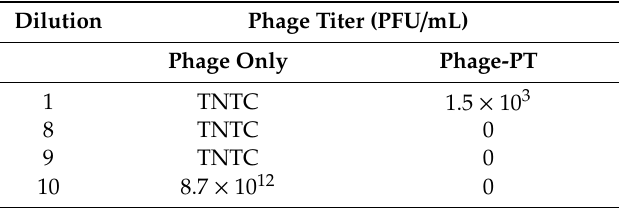
Table 2. E ff ect of phlorotannins (50 µ g / mL) on the number of viable phage after 3 h of exposure at 22 ◦ C.